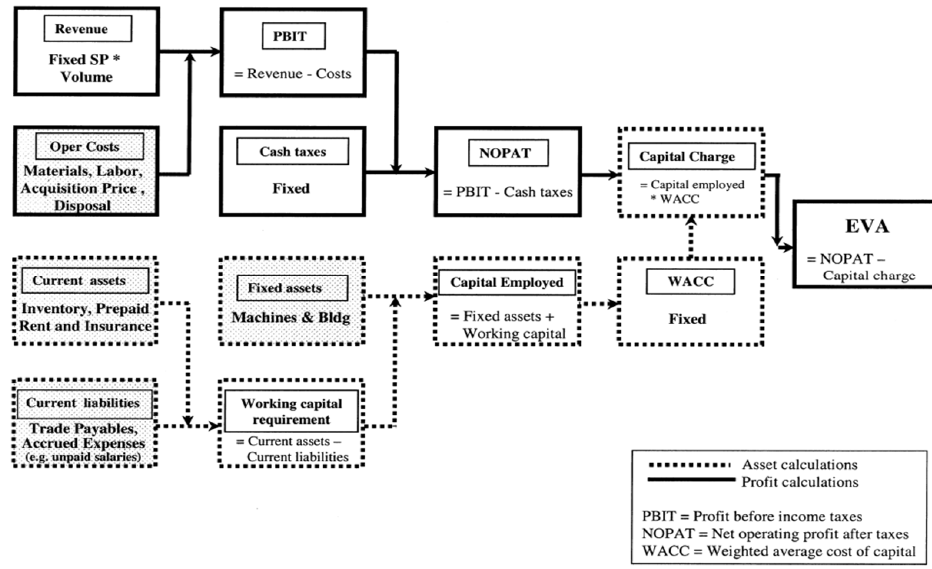
Figure 2 . EVA calculation (Guide and Van Wassenhove 2001). Figure 2. EVA calculation (Guide and Van Wassenhove